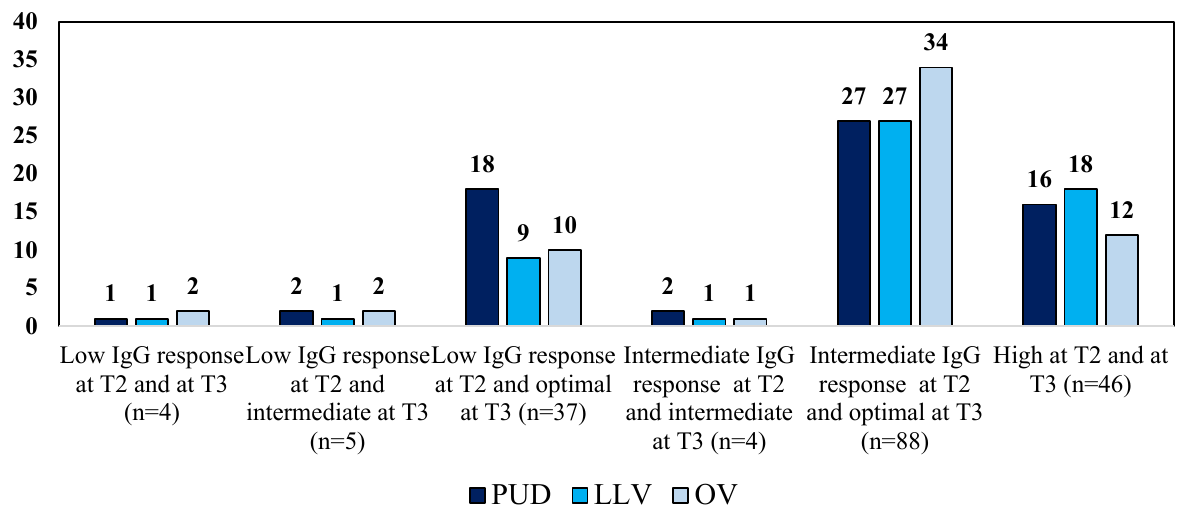
The frequency of patients with PUD, LLV and OV was comparable in patient cohorts